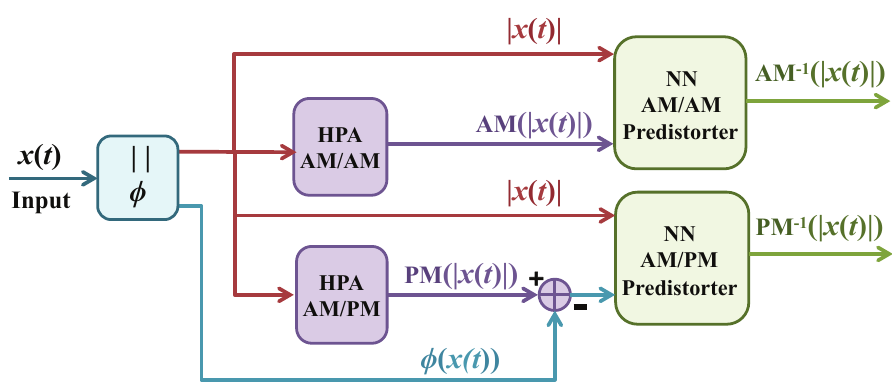
Figure 3. Pre-distorter training phase.